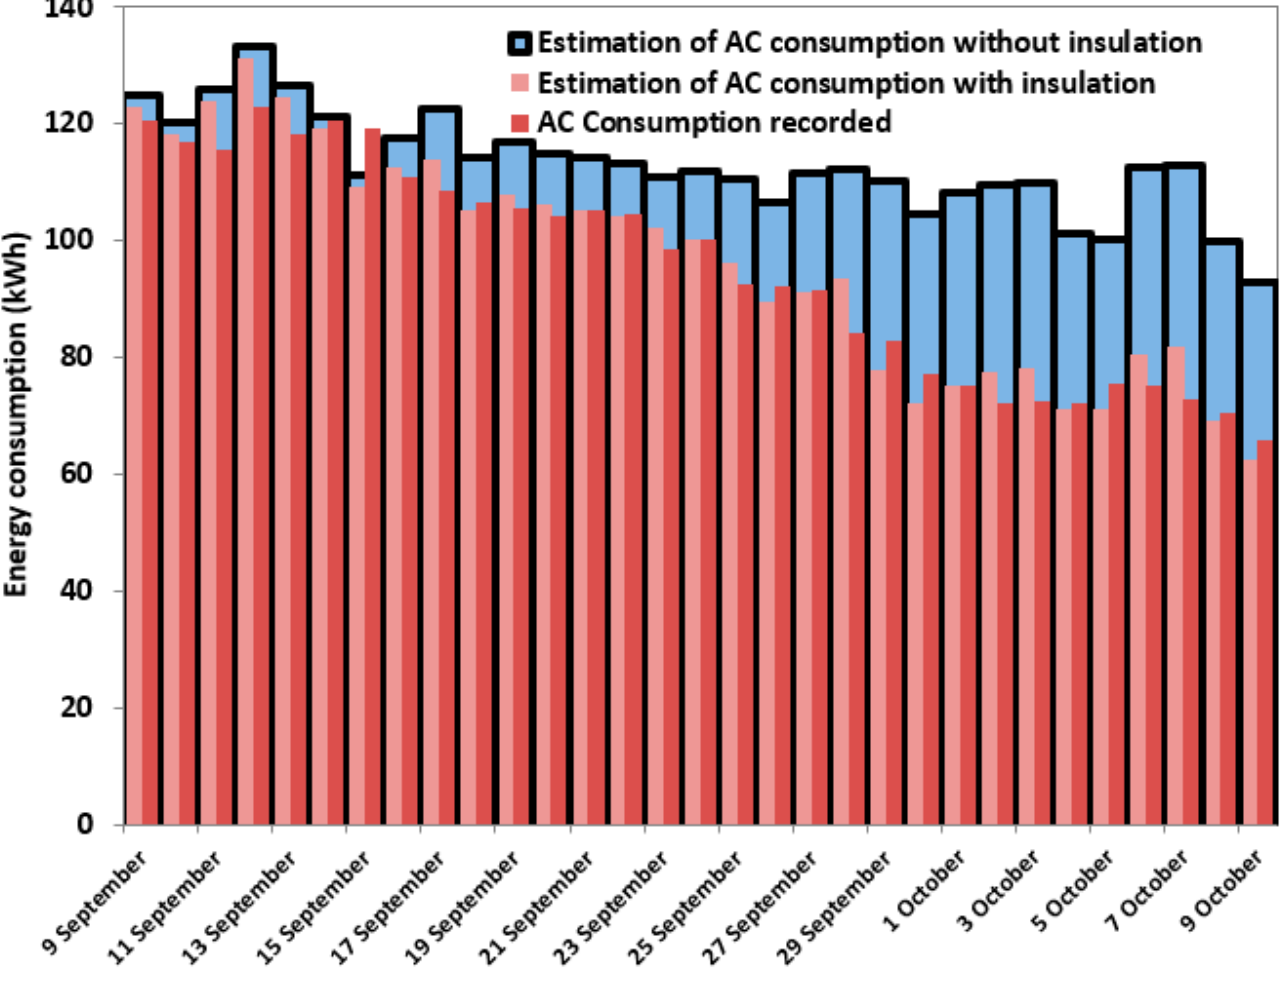
Figure 14. Model theoretical estimation versus recorded daily measurements.